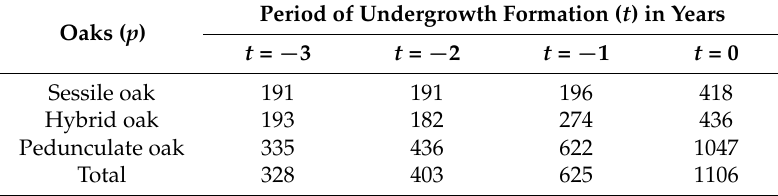
Table 4. Oak trees in the undergrowth density change ( A p,t ) dependent on the formation period, units/ha (Equation (6)). Period of Undergrowth Formation ( t ) in Oaks ( p )